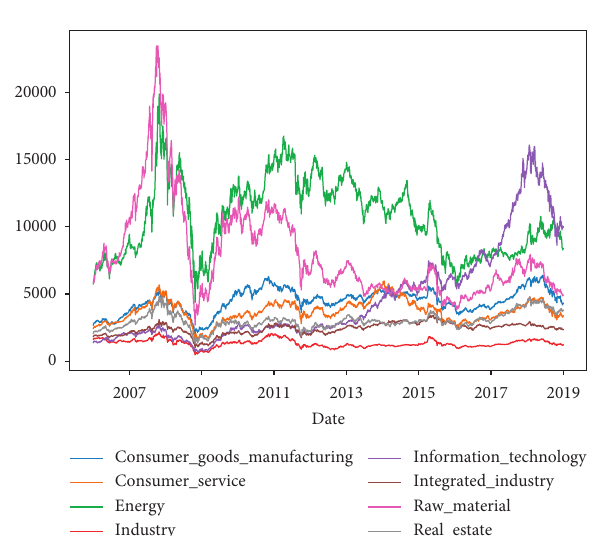
Figure 1: Daily closing prices of industry stock index prices. Source: Wind,